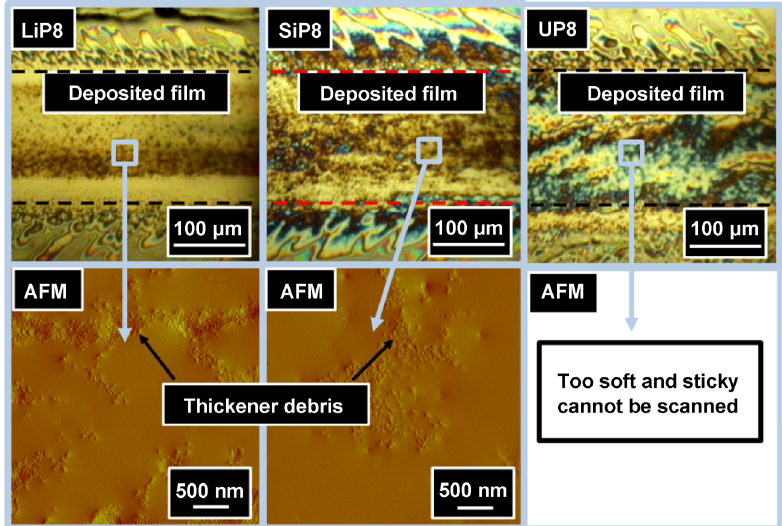
Fig. 5 Thickener-deposited film in the rolling